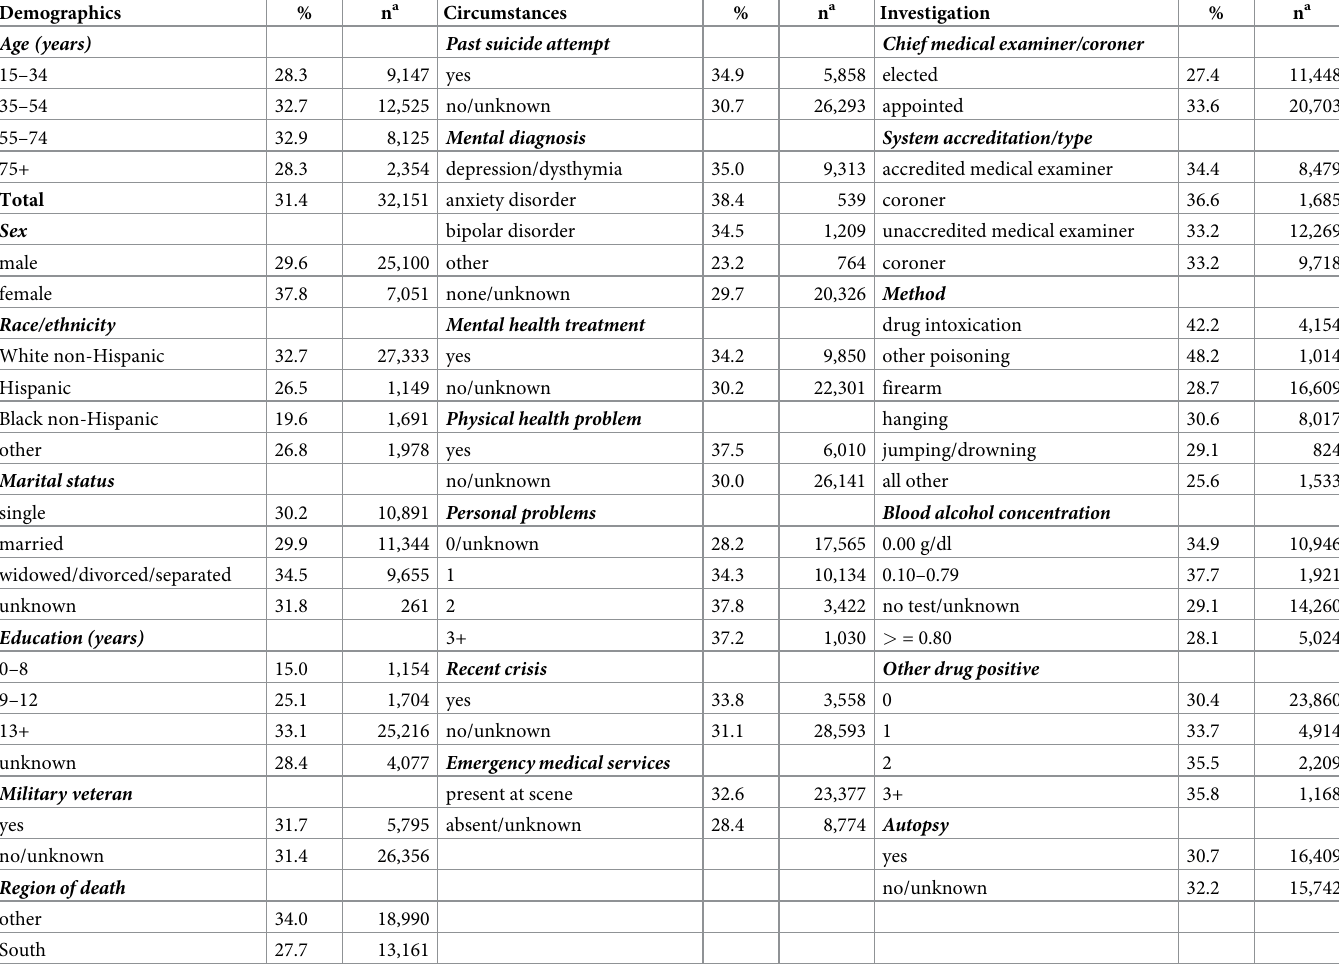
Table 2. Prevalence of suicide notes by decedent demographics, death circumstances, and investigation system characteristics, 17 National Violent Death Reporting System States, 2011–2013.